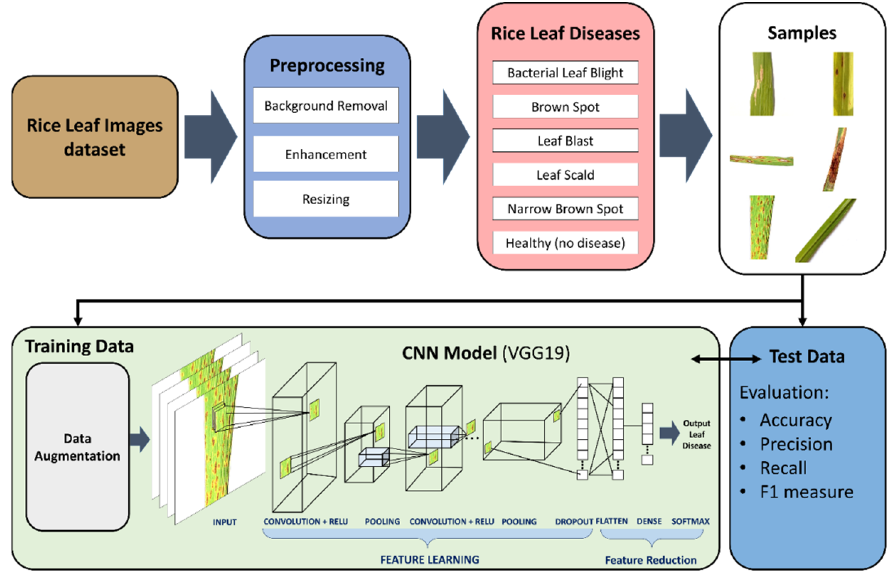
Figure 1. Proposed deep convolutional neural networks (CNN) transfer learning-based approach for leaf disease classification.